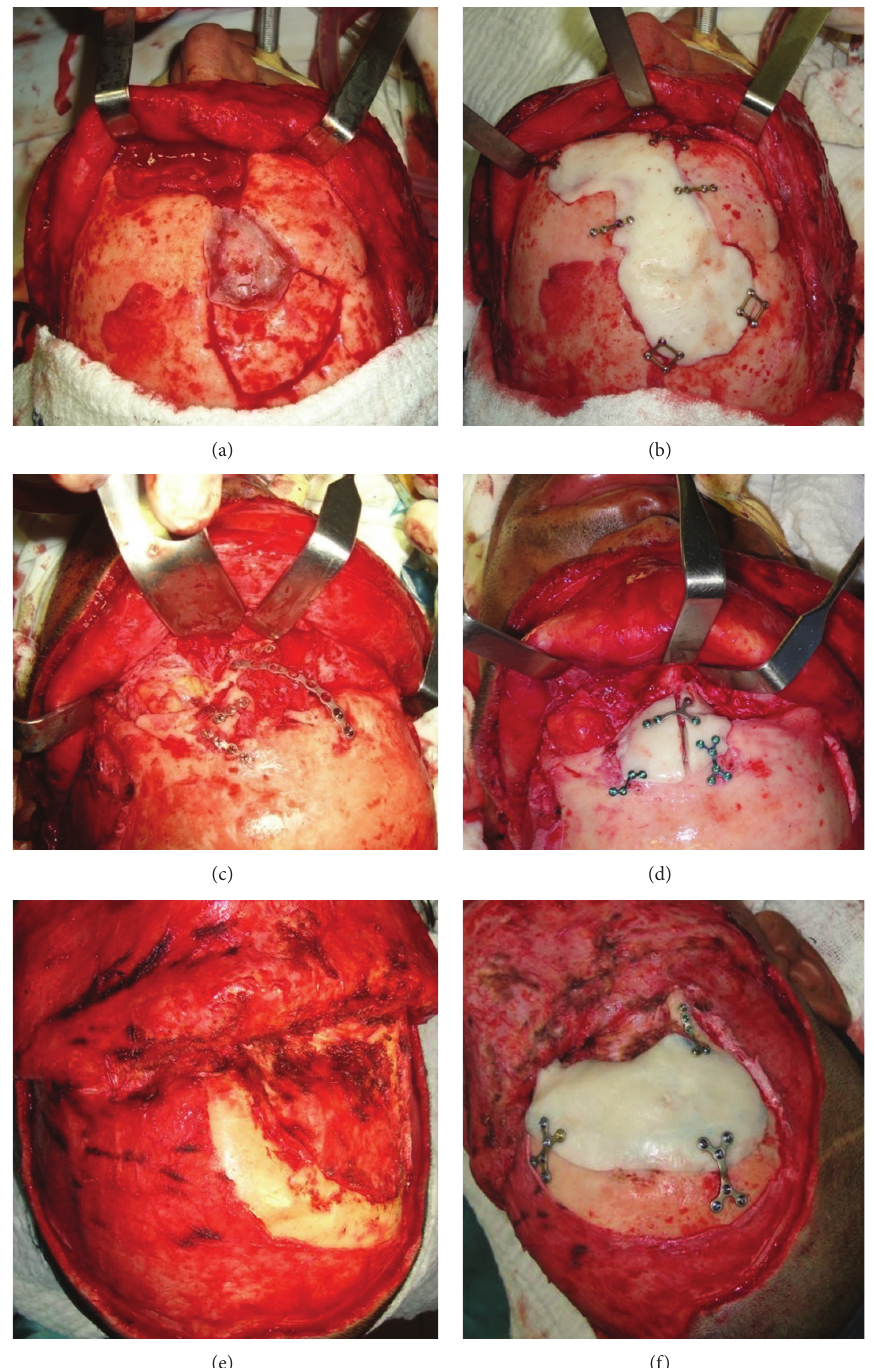
Figure 4: Intraoperative view of the defect and reconstruction with the PMMA implant (Case 1 ((a)-(b)), Case 2 ((c)-(d)), and Case 3 ((e)-